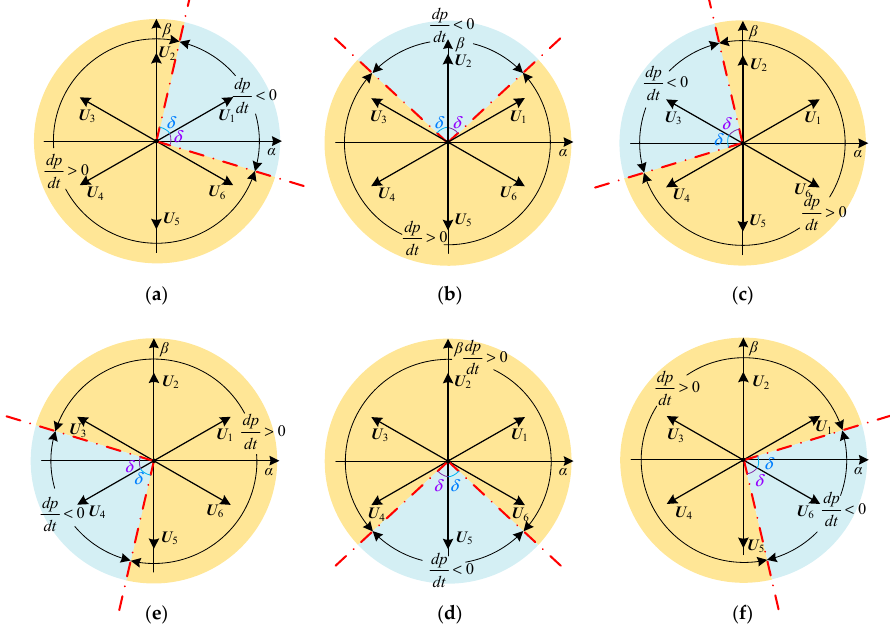
Figure 5. Illustration of areas divided by the synthesized voltage vectors’ effect on active power. ( a ) U 1 , ( b ) U 2 , ( c ) U 3 , ( d ) U 4 , ( e ) U 5 , and ( f ) U 6 .